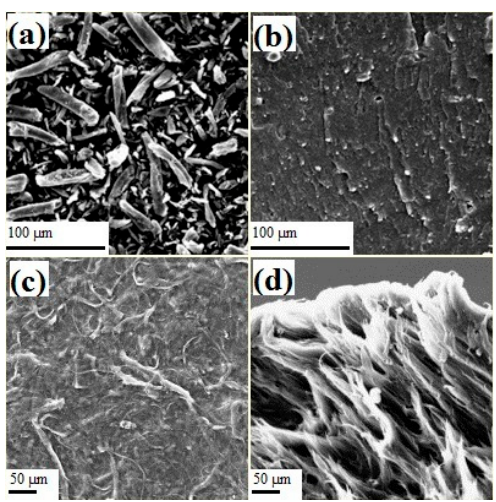
Figure 1. SEM images. ( a ) MCC; ( b ) PVA/MCC-20%; ( c ) surface topography of the PVA/MFC-10% composite, ( d ) fracture surface of the PVA/MFC-10% composite [27,29] (Reprinted with permission from [27]. Copyright 2014, Elsevier; Reprinted with permission from [29]. Copyright 2012, Elsevier.).